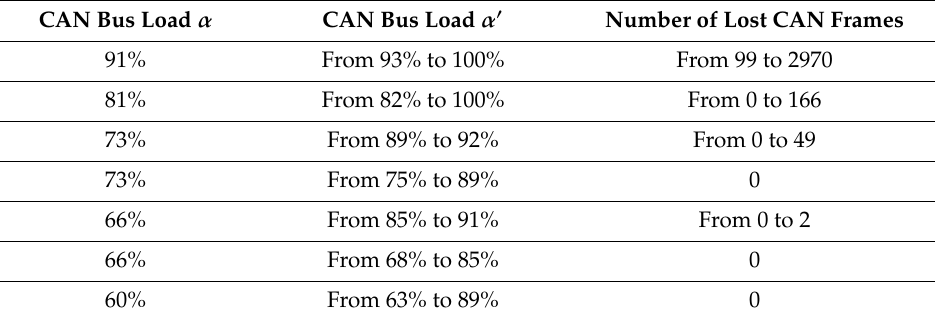
Table 4. Summary of the number of lost CAN frames at di ff erent values of α and α (cid:48) . CAN Bus Load